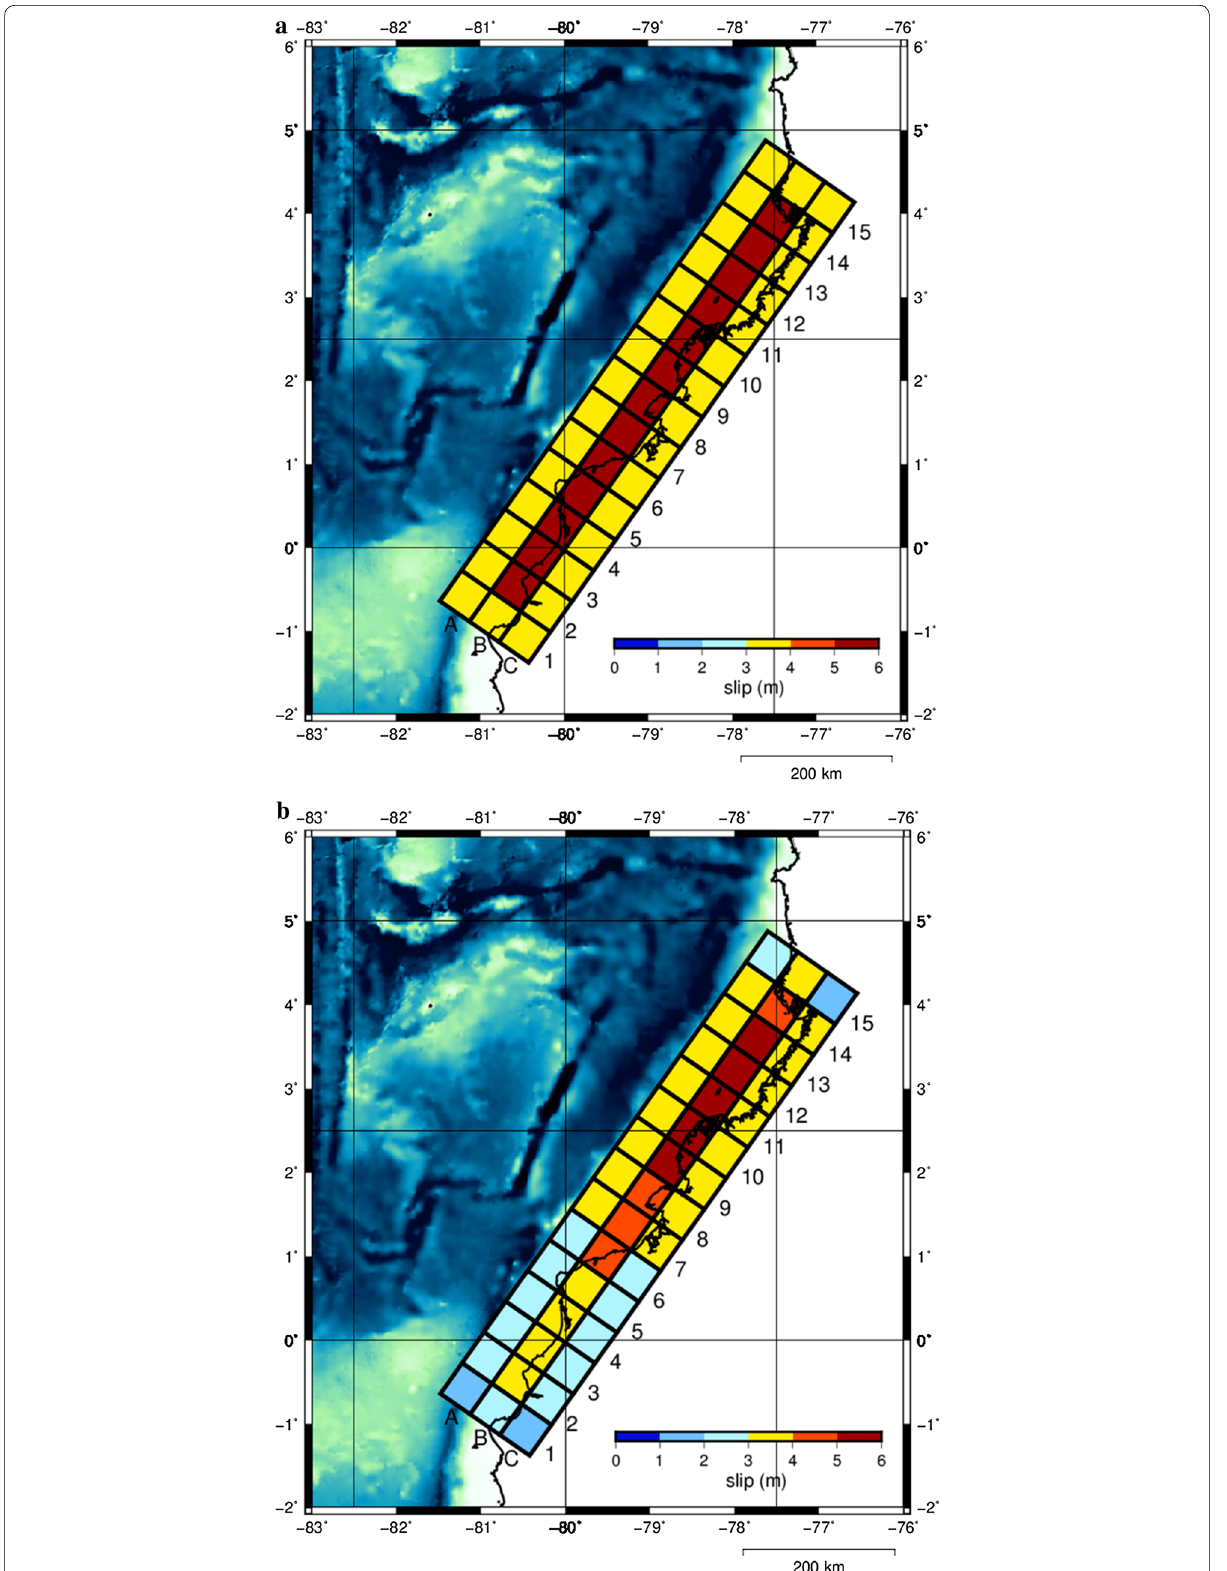
Fig. 3 Result of the resolution test. a Assumed slip distribution that consists of 3‑ and 6‑m slips and b estimated slip